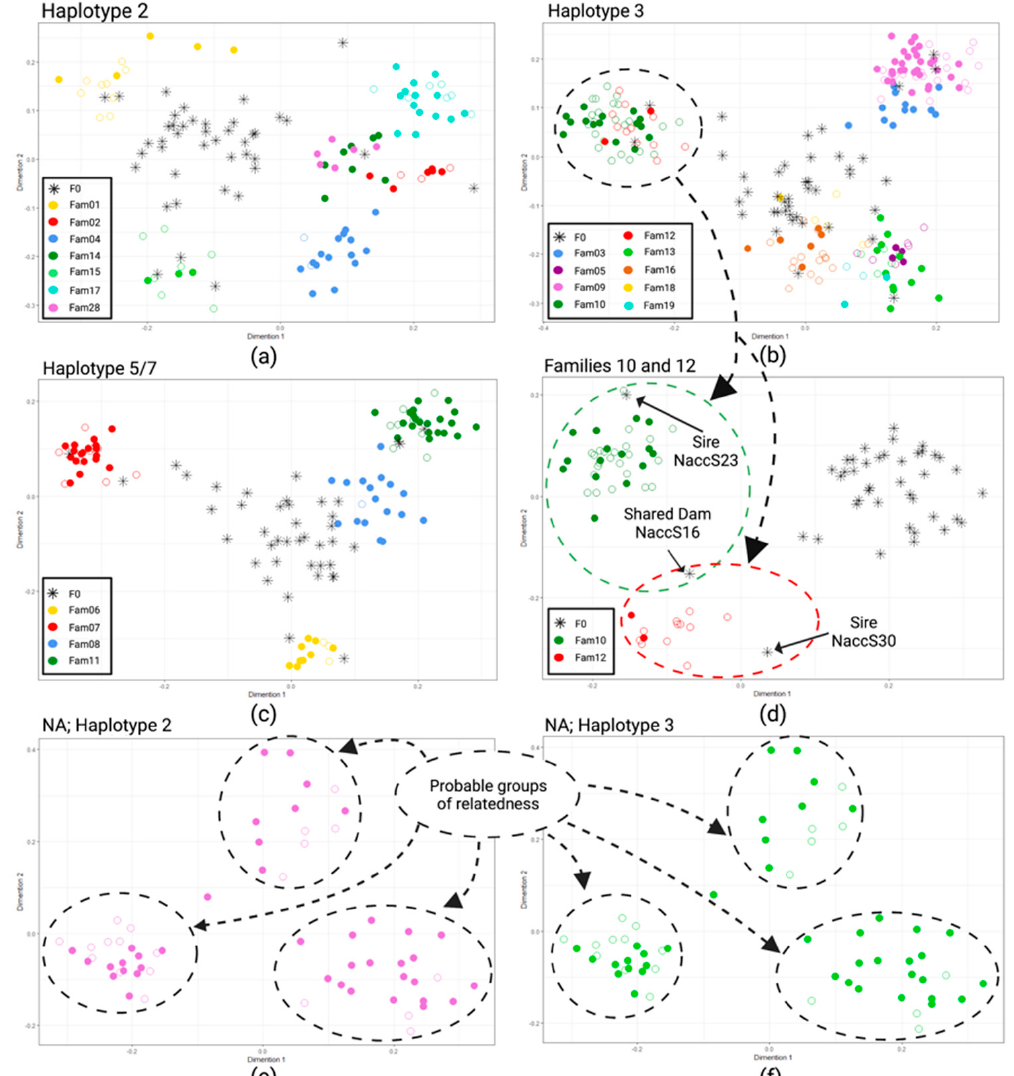
Figure 2. Results of MDS analyses performed on pairwise Sørensen’s distance matrix among F0 and F1 with mitochondrial haplotype 2 ( a ); F0 and F1 with mitochondrial haplotype 3 ( b ) and F0 and mitochondrial haplotypes 5 and 7 ( c ). Individuals of two half-sib family groups (10 and 12), that in the first run were not distinguishable, were included in a second run, excluding all other F1s to show the usefulness of a hierarchical approach in also distinguishing related families; the common dam and the sires of the two families are also highlighted ( d ). The same approach was used on animals for which the parental information was not available, having mitochondrial haplotype 2 and 3 ( e , f ), respectively. In all figures, full and empty circles represent alive and dead animals, respectively (created with Biorender.com, accessed on 13 September 2022). NA = non-allocated.